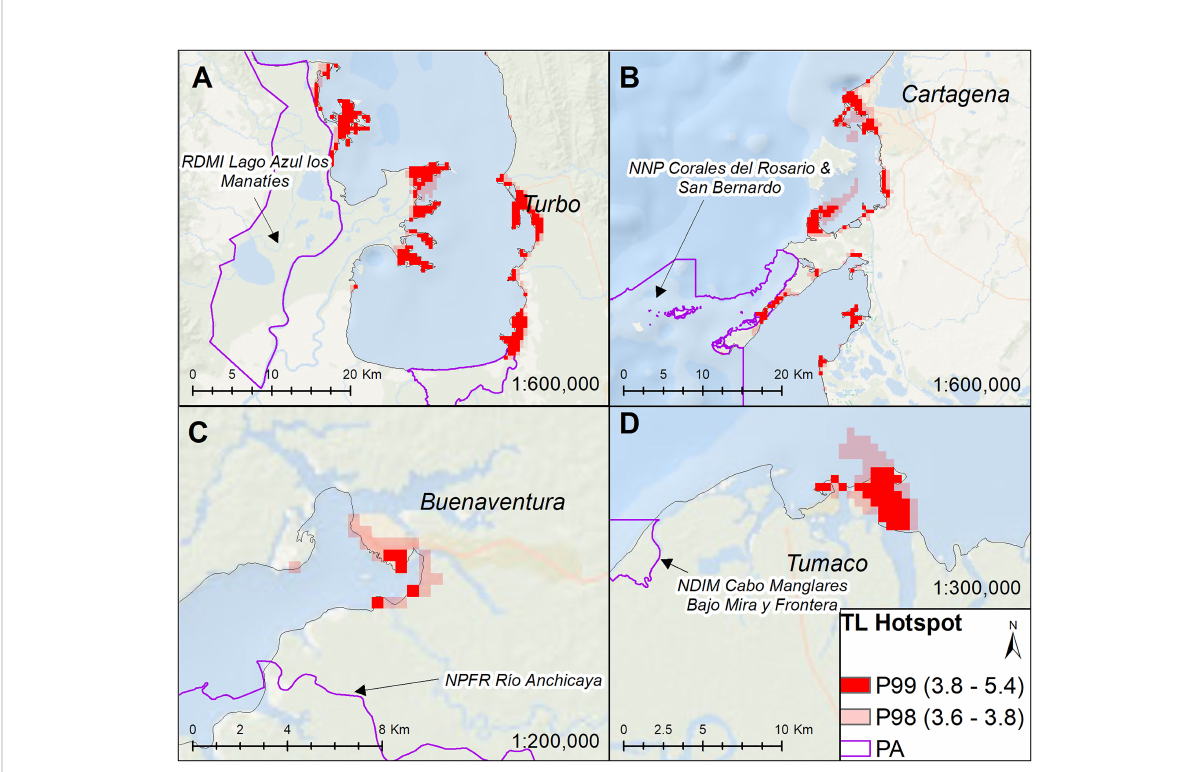
FIGURE 3 Threat hotspots. (A) : Turbo — Antioquia , (B) : Bah ı ́ a de Cartagena — Bol ı ́ var , (C) : Buenaventura — Valle del Cauca , and (D) : Tumaco — Nariño . The location of these hotspots within the national territory of Colombia is shown in Figure 2. TL values (in brackets) were ranked by Percentile 98 (P98) and Percentile 99 (P99) revealing threat hotspots. RDIM, Regional District of Integrated Management; NDIM, National District of Integrated Management; FFS, Fauna and Flora Sanctuary; NPFR, National Protective Forest Reserve; RNP, Regional Natural Park; PA, protected